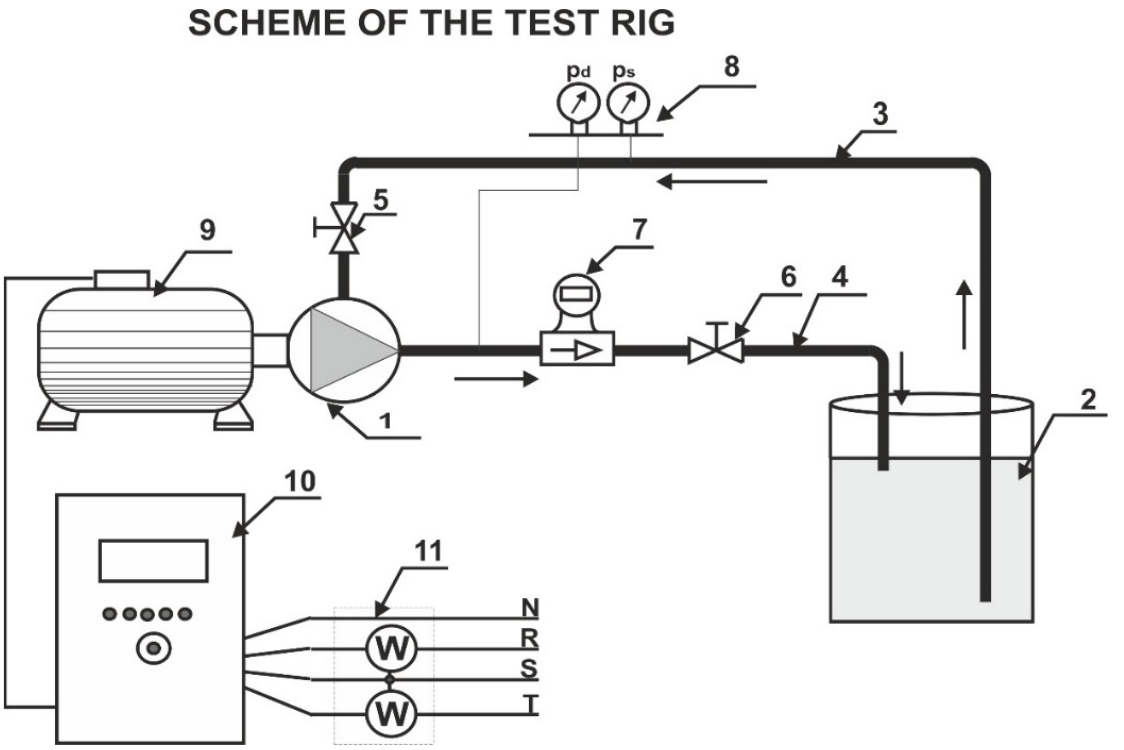
Figure 7. Scheme of the test rig: 1— model pump; 2 — open tank; 3 —suction pipe ; 4— discharge pipe; 5—shut- off valve; 6 — regulating gate valve; 7 — electromagnetic flow meter; 8 —measuring manom- eters; 9 — electric motor; 10 — inverter; 11 —measurement of electric power using wattmeters in the Aronna system. Table 3. List of instruments used in the measurements.